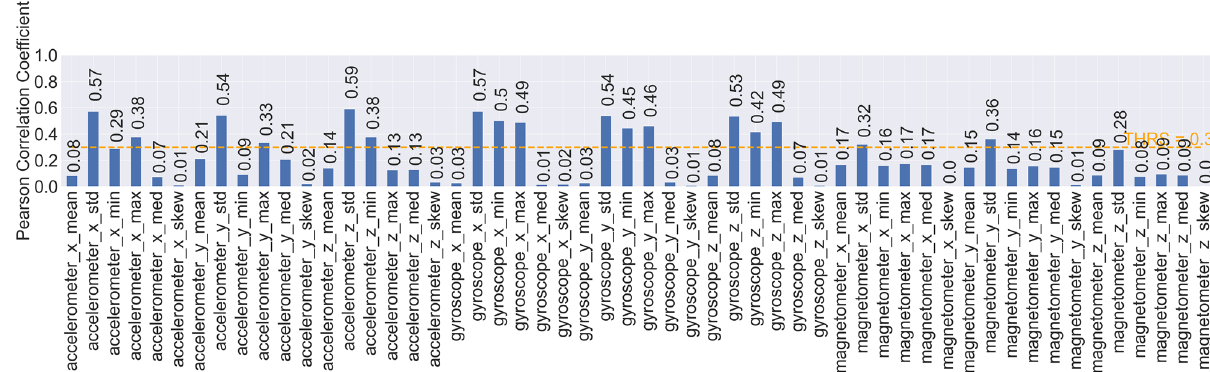
Figure 3. Filter-based Feature Selection based on the absolute value of Pearson Correlation coefficient determined for features and label in a numerical